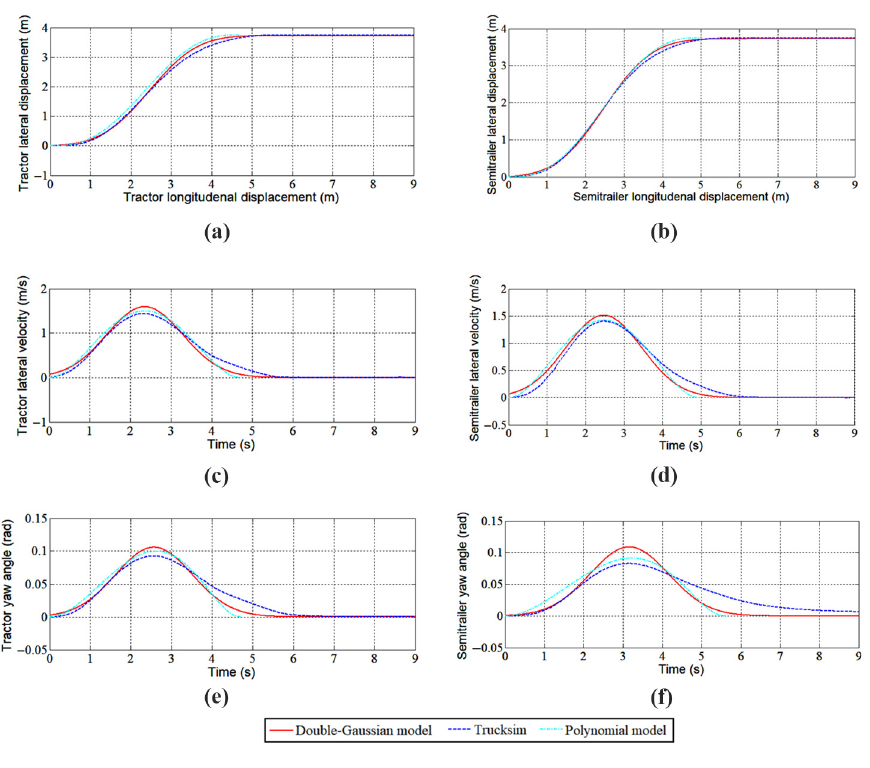
Figure 6 Contrasts in longitudinal deceleration